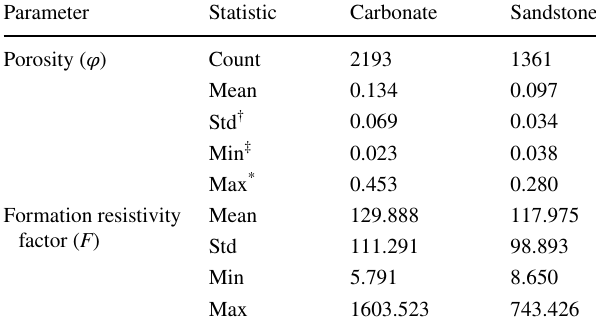
Table 2 Statistics of the studied dataset